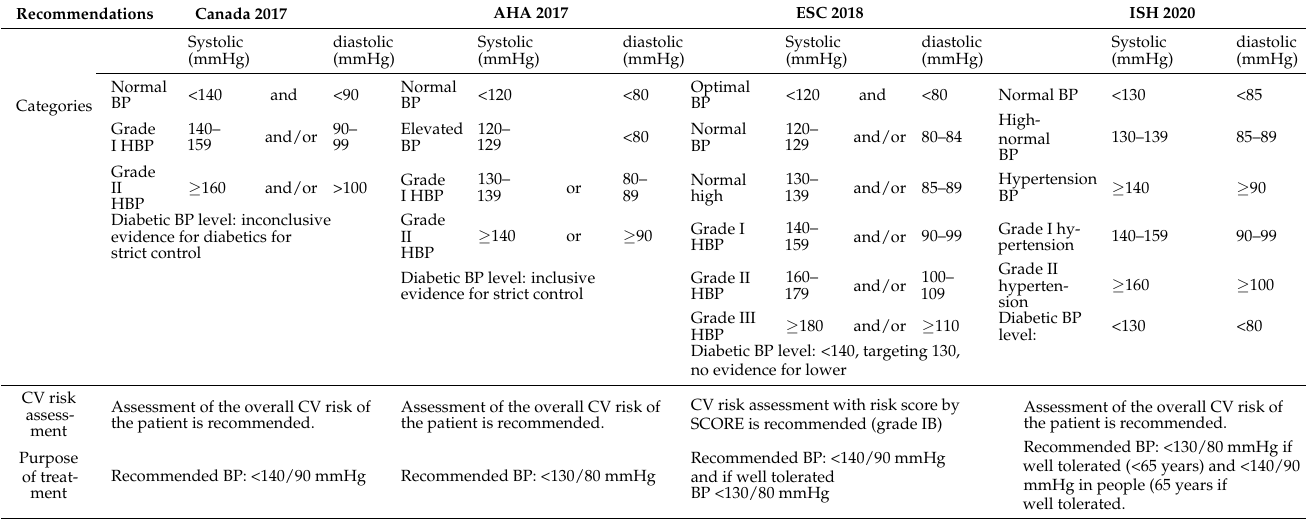
Table 1. Summary of hypertension grades and treatment objectives for a patient with essential high blood